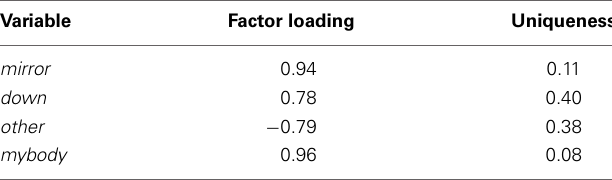
Table 2 | Factor analysis for body ownership